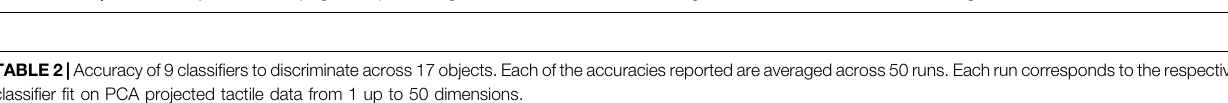
FIGURE11| Theaccuracywhenclassifyingthe objects using nine differentmodels when using thethree different fi ltersforincreasingnumber ofPCA dimensions.